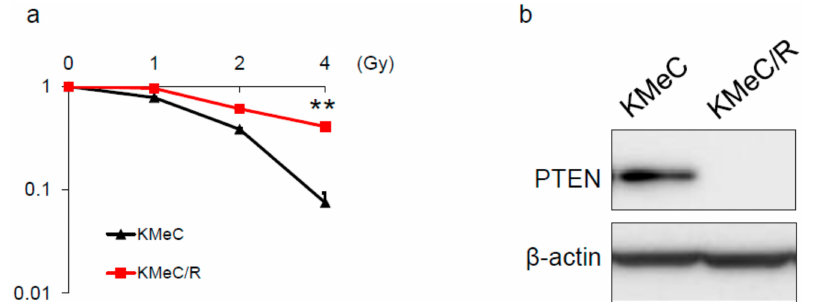
Figure 1. Establishment of the radioresistant KMeC cell line and the expression level of PTEN. ( a ) Results of colony formation assay using KMeC cells and their radioresistant ones. The assay was performed 14 days after the irradiation. ( b ) The protein expression level of PTEN in KMeC and KMeC / R cells. ** p < 0.01, for di ff erences between KMeC and KMeC / R cells. Data are expressed as the mean + SD ( n =